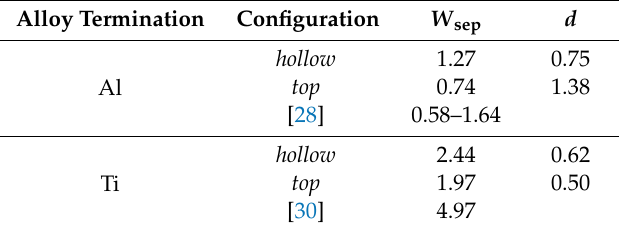
Table 2. Work of separation (in J / m 2 ) and interface distance ( d in Å) at the interface TiAl / TiO 2 (110) O